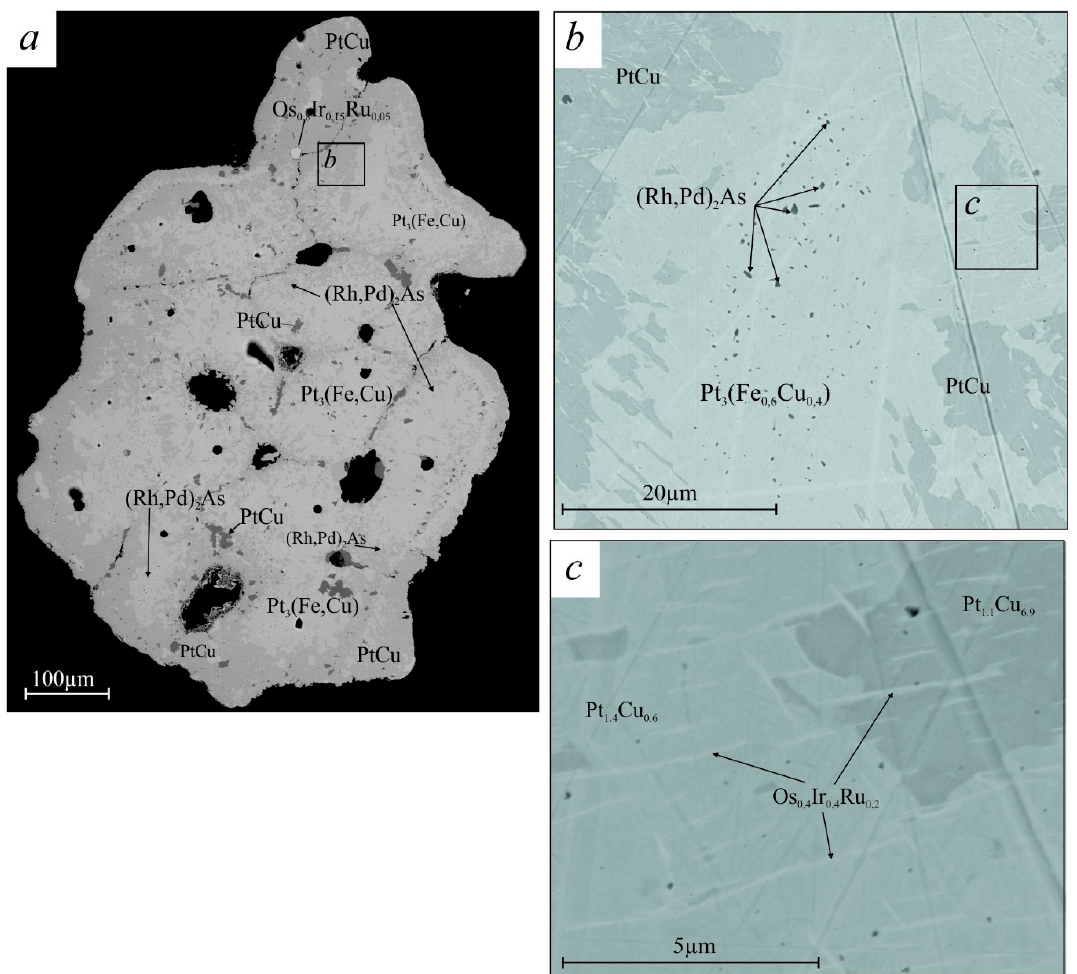
Figure 2. Back-scattered electron (BSE) image showing multiphase Grain No. 1 ( a ) A placer grain of Pt 3 (Fe,Cu) consists of a rim of Cu-enriched alloy phase (hongshiite PtCu) with inclusions of rhodarsenide (Rh,Pd) 2 As. ( b , c ) The exsolution micro-lamellae of rutheniridosmine (the decomposition of a solid solution) in isoferroplatinum and platarsite (PtAsS). The composition of measurement points is listed in Table 4. White—isoferroplatinum (Pt,Fe) and osmium (Os); light gray and gray—platarsite (PtAsS), cooperite (PtS), and sperrylite (PtAs); rectangular contours—the position of the microsites “b” and “c”. Explanation in the